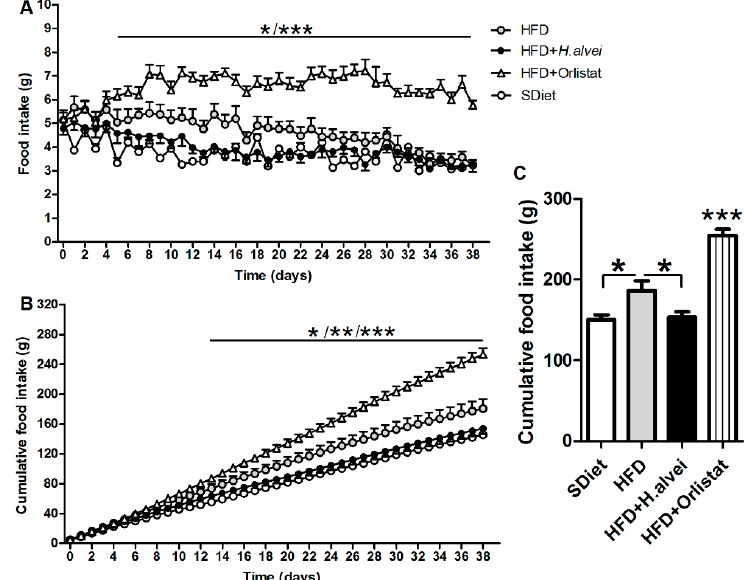
Figure 5. Effects of H. alvei HA4597™ and orlistat on food intake in high-fat-diet (HFD)-fed